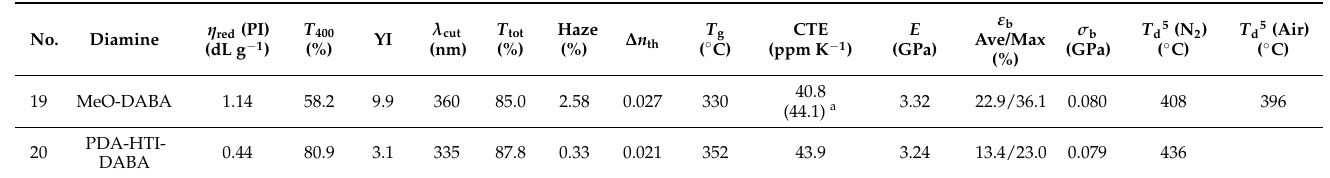
Table 3. Film properties of H-PMDA-based PIs obtained using monoamide-type and amide-imide- type